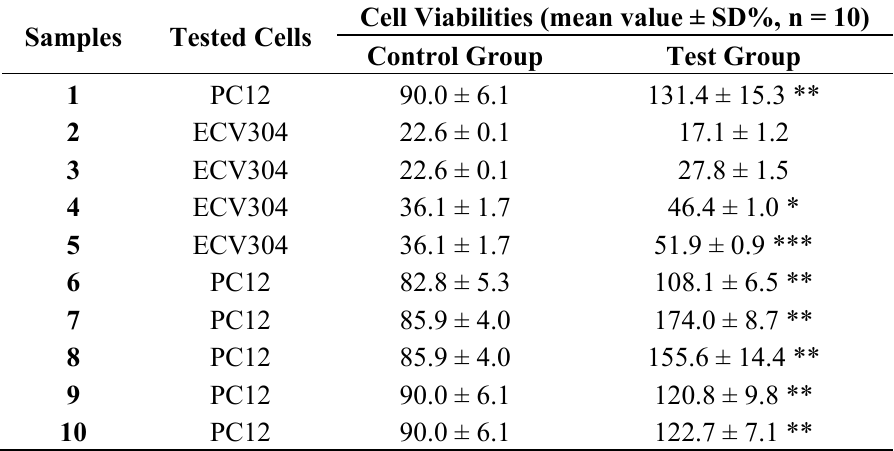
Table 3. Anti-hypoxia effects of 1 and 4 – 10 on anoxic tested cells (50